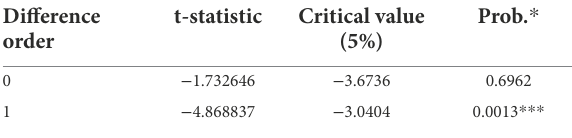
TABLE 5 Ln(s) ADF Test